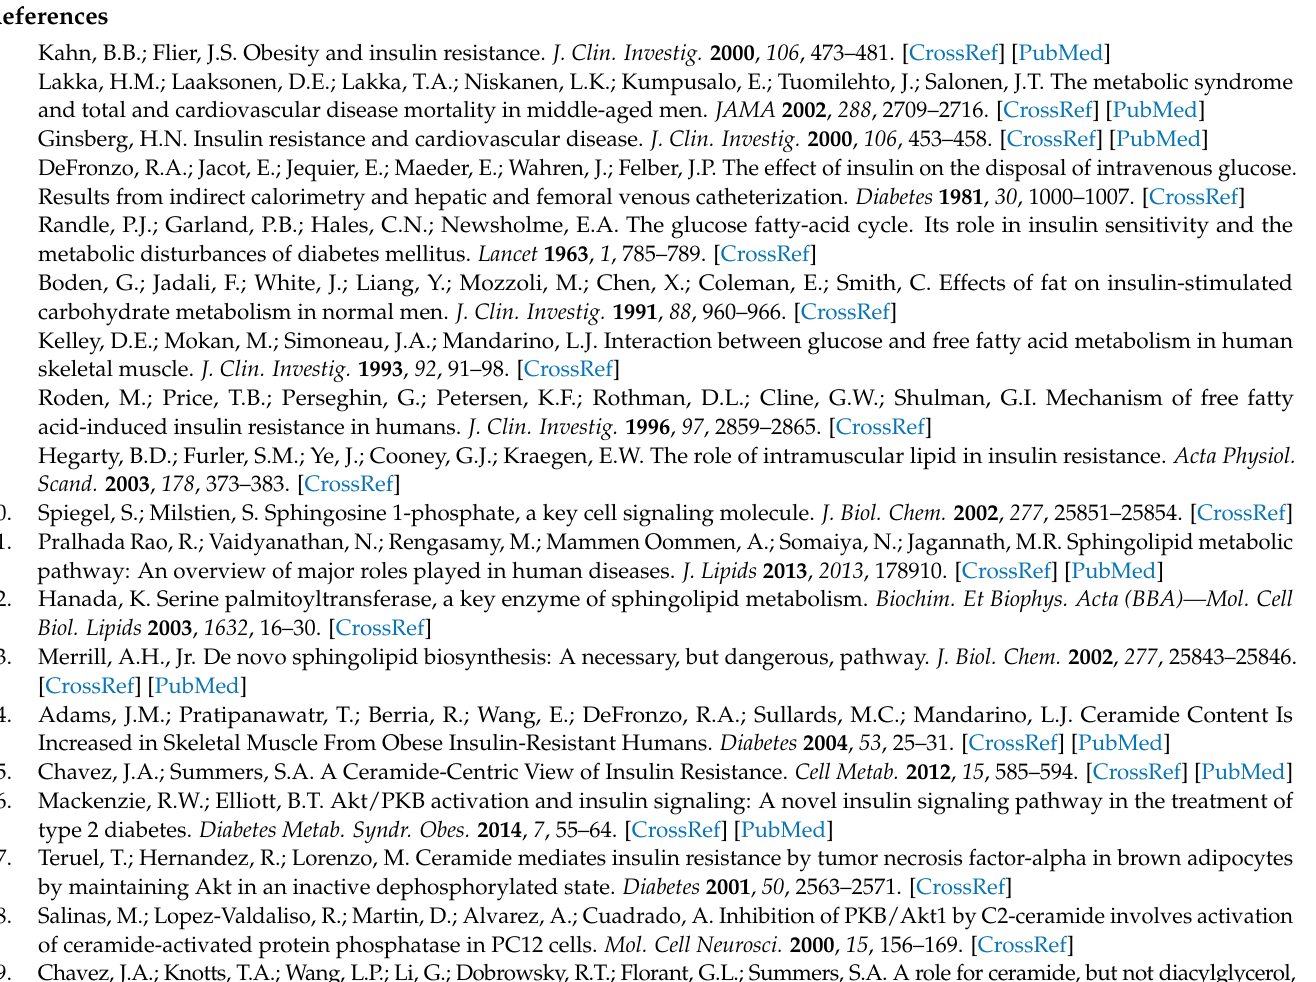
gel for Figure pAkt(S473)/Akt, Figure S3: Full unedited gel for Figure CPT1B, Figure S4: Full unedited gel for Figure FABPpm, Figure S5: Full unedited gel for Figure GLUT4, Figure S6: Full unedited gel for Figure FATP1, Figure S7: Full unedited gel for Figure CD36, Figure S8: Full unedited gel for Figure PI3K, Figure S9: Full unedited gel for Figure pIRS-1(S1101)/IRS-1 and